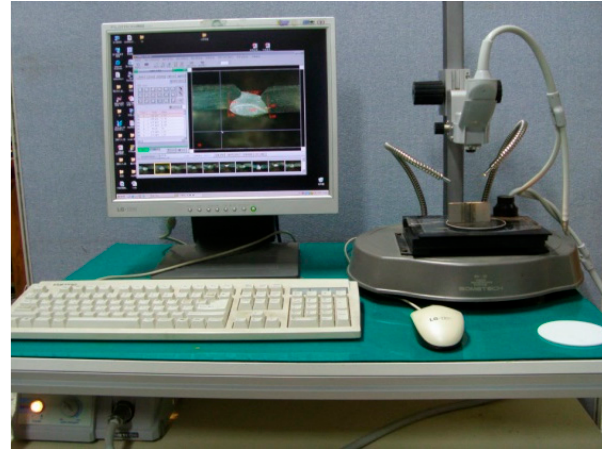
Figure 4. Optical